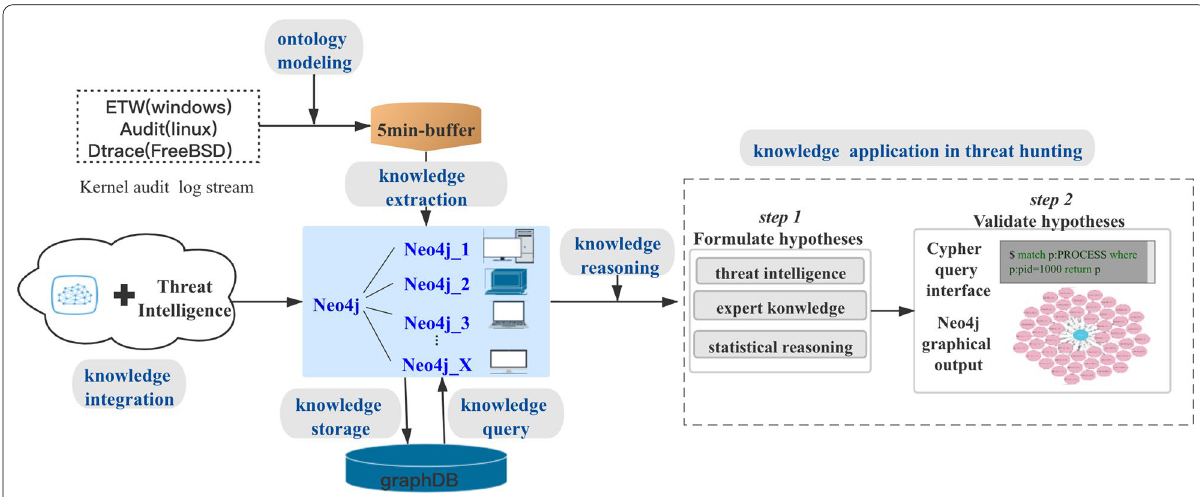
Fig. 1 System architecture of the hunting